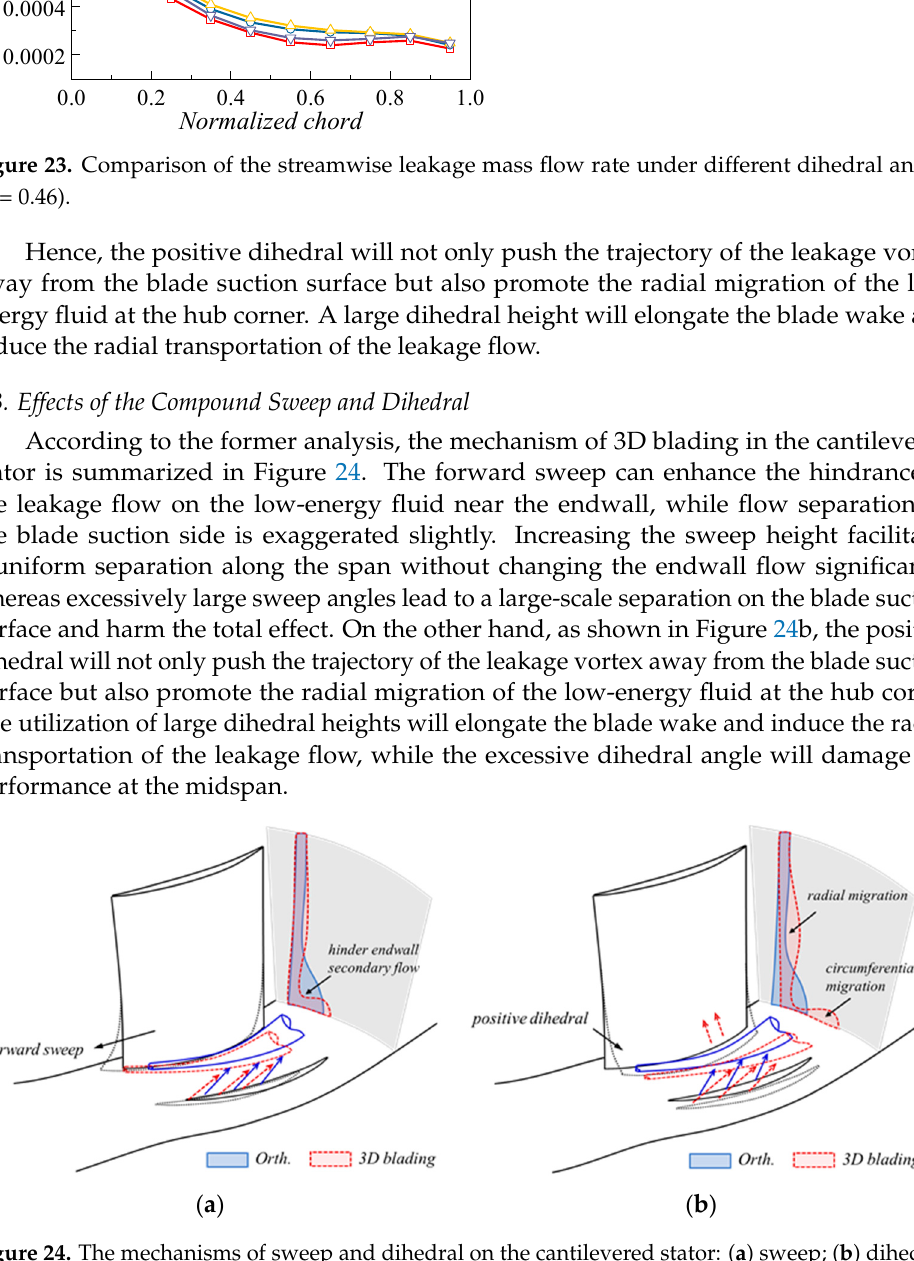
Figure 25. Radial distribution of sweep and dihedral for the 3D cantilevered stator.